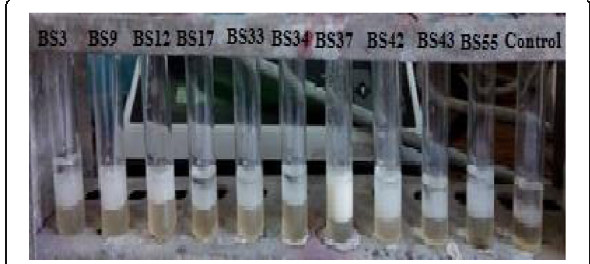
Fig. 3 Oil spreading assay of bacterial isolate BS37 Fig. 4 Emulsifying assay of the tested bacterial